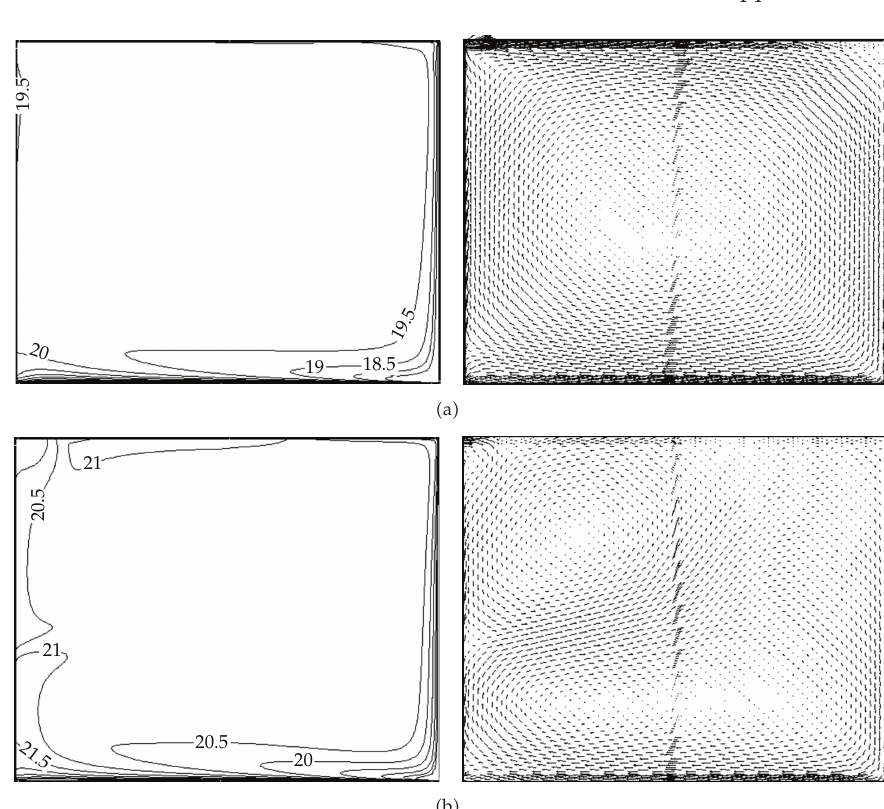
Figure 5: The velocity and temperature distributions for LSV at T fl (cid:8) 30 ◦ C, q ow (cid:8) − 100W/m 2 , (cid:5) a (cid:6) u in (cid:8) 0.3m/s, and (cid:5) b (cid:6) u in (cid:8)